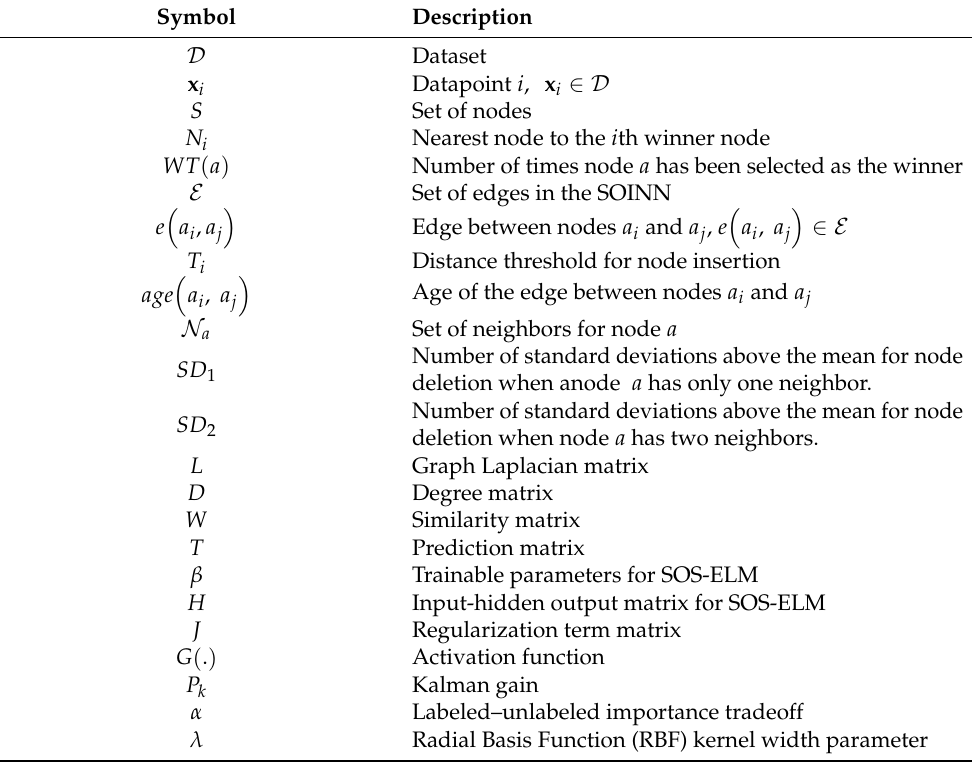
Table 1. List of symbols for the ESOINN and